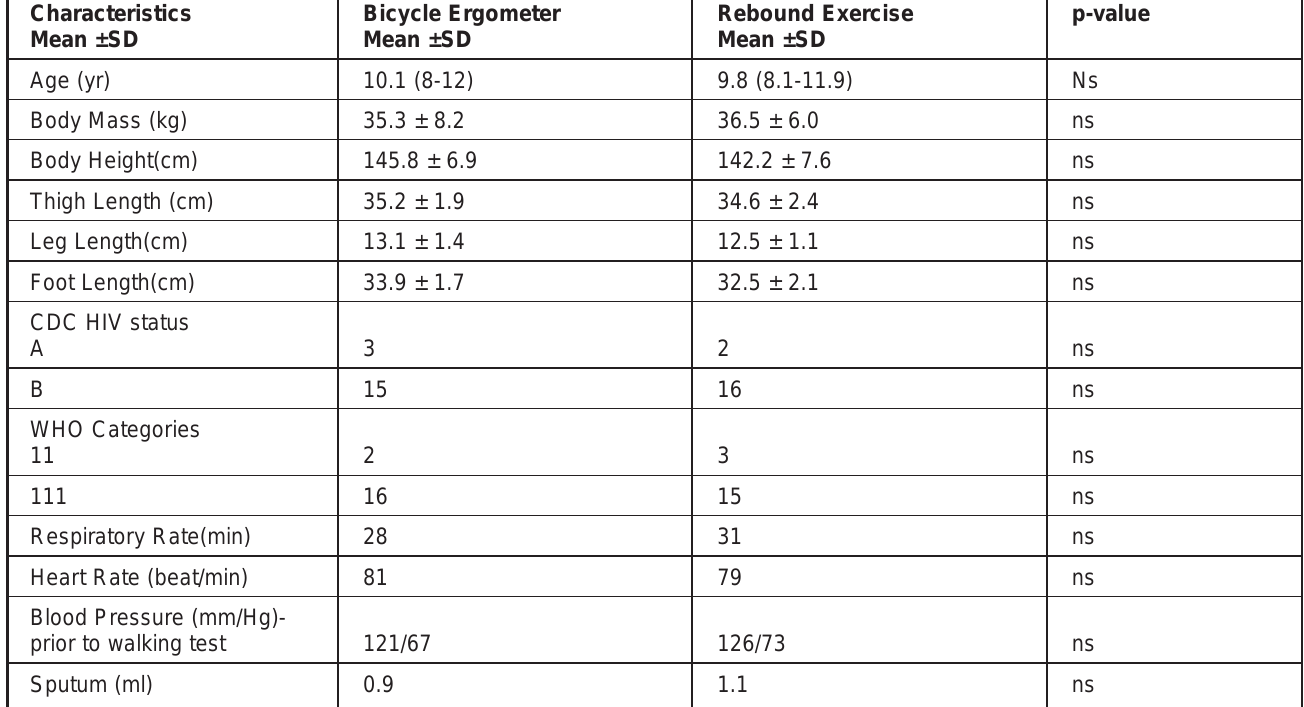
Table 1: Baseline Characteristics